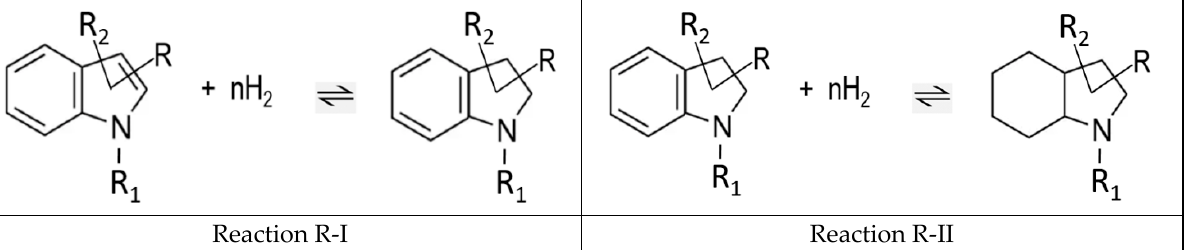
Figure 5. Reversible reactions of the partial hydrogenation (reaction R-I) and the consequent full hydrogenation of the indole derivatives (reaction R-II).